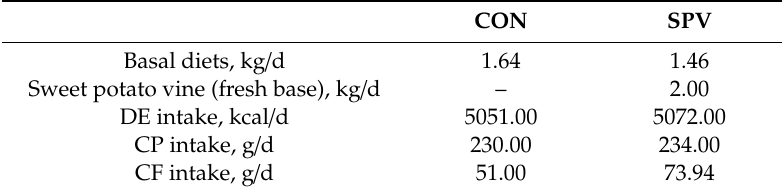
Table 2. The feeding strategy for the Chinese Meishan